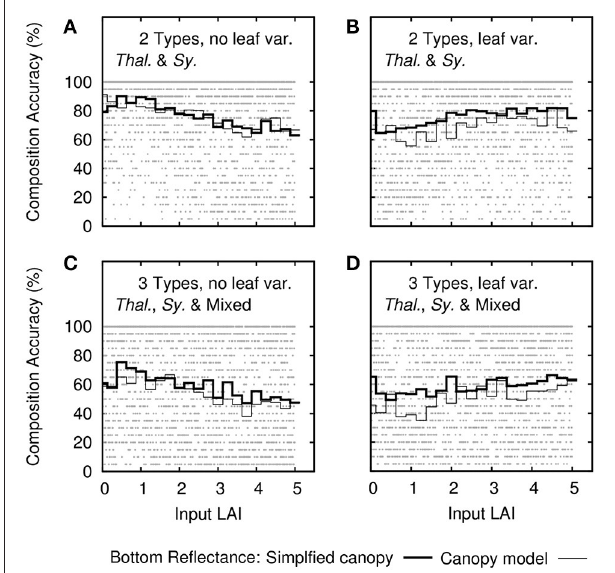
FIGURE 10 | Sensitivity analysis results for the accuracy of canopy composition type determination as function of leaf area index (LAI). Each dot is the overall accuracy from the uncertainty propagation (20 repeats) of each of the 2,500 noise-perturbed self-inversions. Dark lines are the mean accuracy binned in steps of 0.25 in LAI. Thin lines are the mean accuracy when input bottom reflectances are drawn directly from the canopy model results. Treatments include (A,B) the model of two bottom types and (C,D) three bottom types. Each is repeated (B,D) with and (A,C) without leaf level